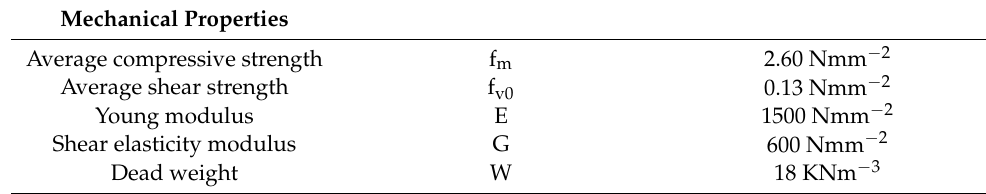
Table 1. Mechanical characteristics of masonry material for inspected SUs